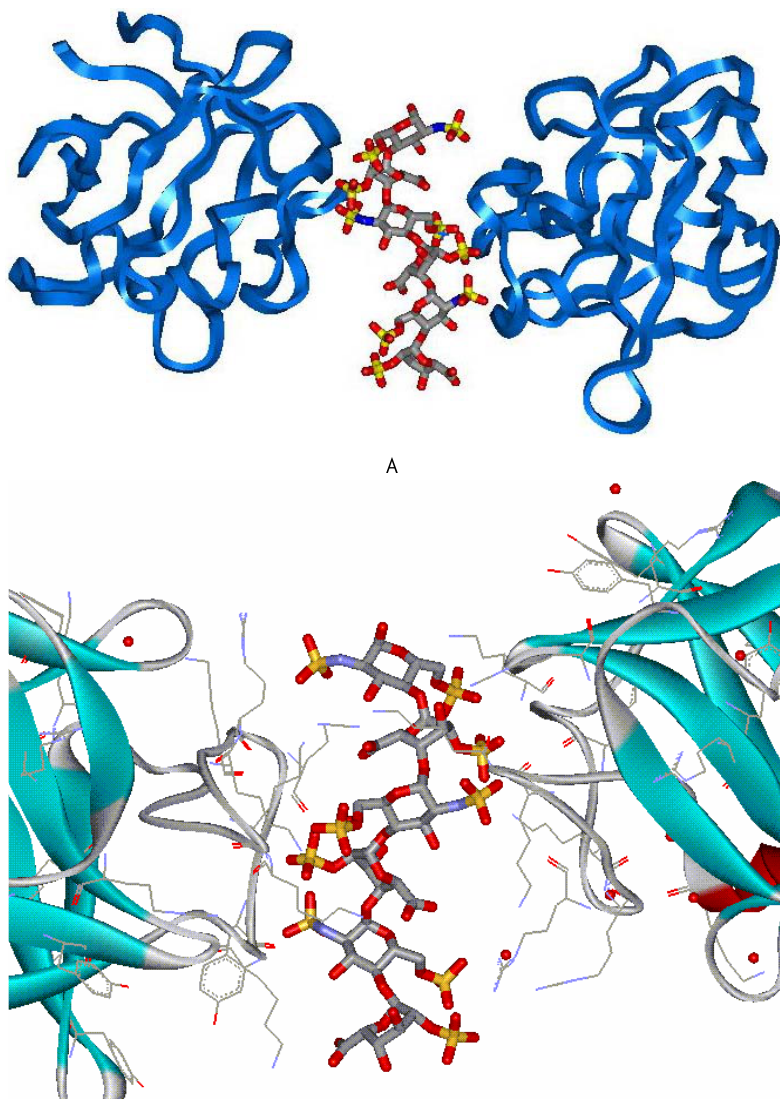
Fig. 6 – FGF-1 and a heparin oligosaccharide: A: crystal structure of the complex (from coordinates in the PDB file 1AXM). Two copies of the FGF-1 monomer are depicted in a blue ribbon representation, with the heparin as in Fig. 5; B: An expansion of the area around the heparin molecule, with amino acid sidechains shown as thin sticks. Each of the FGF-1 molecules makes close contacts with sulfates in one complete cluster of three (see Fig. 5) and one or two sulfates from a subsequent cluster. The whole structure is not in fact symmetrical, and the two FGF-1 molecules are interacting with different sequences, but recognition depends in this case more strongly on a particular pattern of sulfates in three dimensions than on the sequence which presents that